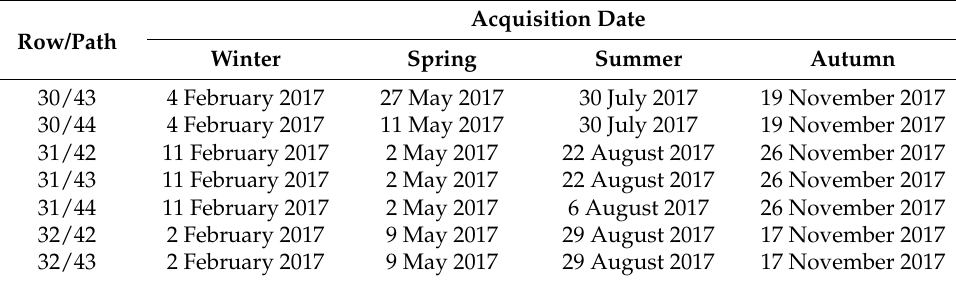
Table 2. Path/Row and acquisition dates of utilized images for Landsat 8. Row/Path